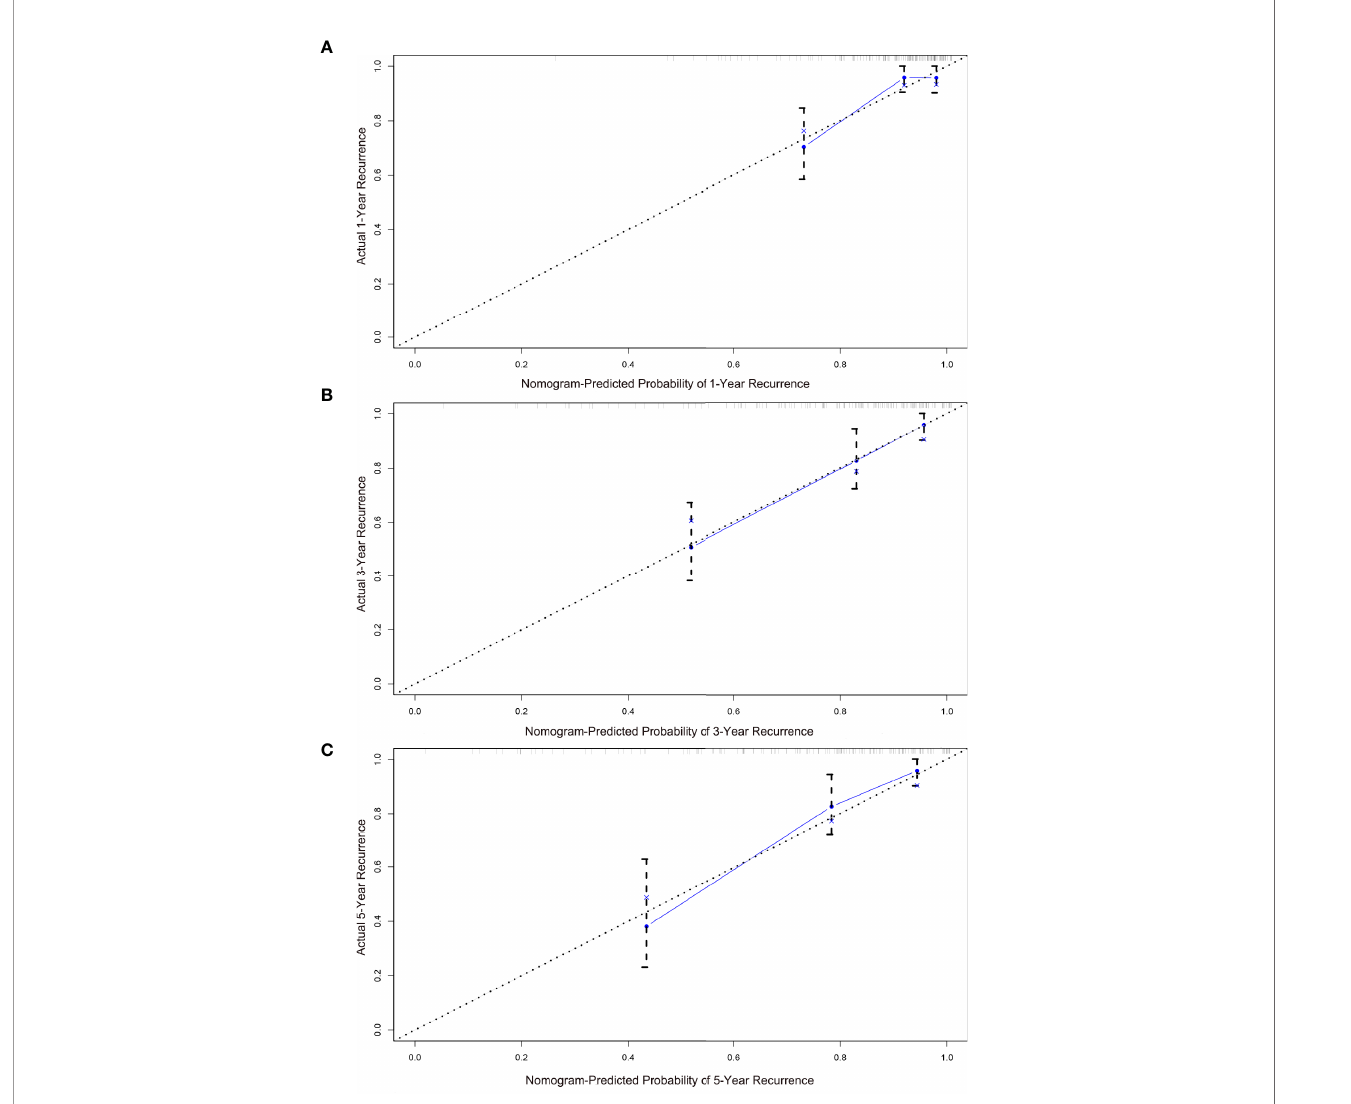
FIGURE 4 | Calibration plots for the nomogram predictions of (A) 1-, (B) 3-, (C) 5-year IV-RFS in the training cohort. The nomogram-predicted probability is plotted on the x -axis, and actual recurrence is plotted on the y -axis. The gray dotted line represents the ideal curve of the calibration models. The blue broken line demonstrates the actual predictive accuracy, the bootstrap-corrected estimates are visually shown by blue X, and vertical bars represent the 95%